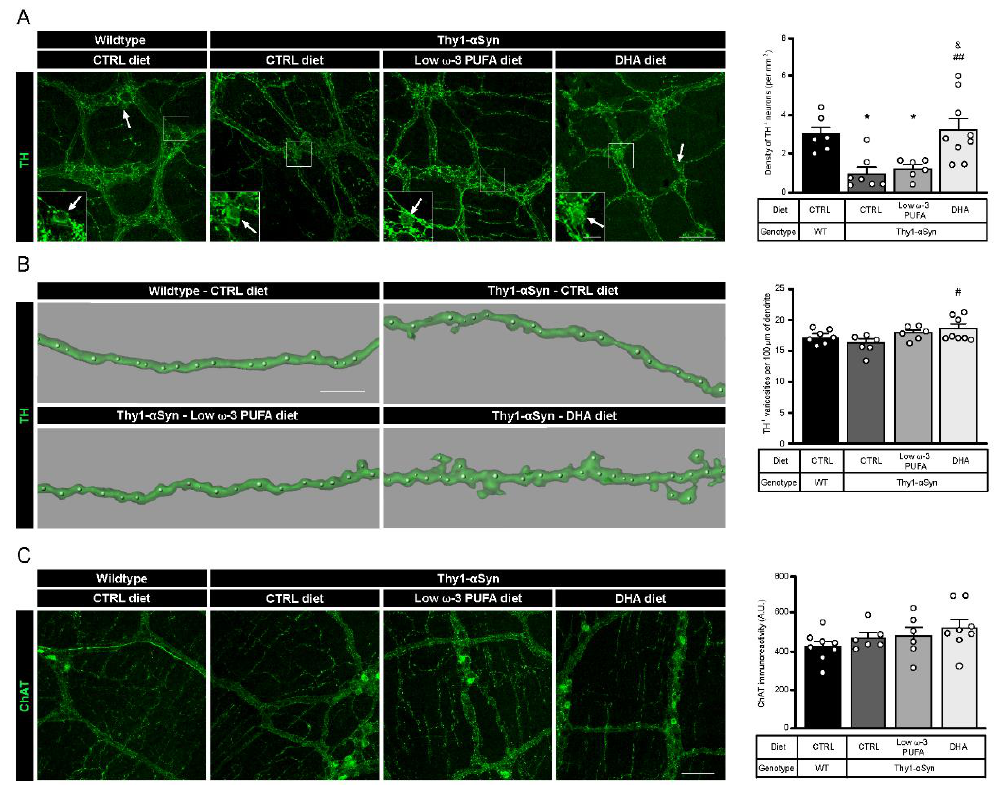
Figure 1. A DHA-enriched diet restores dopaminergic neuron integrity. ( A ) Photomicrographs of enteric TH + neurons (green) and their cell body, as indicated by the white arrow. They show a lower number of dopaminergic cell bodies in the myenteric plexus in the Thy1-αSyn model compared with the wild-type littermates. However, a DHA-enriched diet protected against the decrease in dopaminergic neuron level (one-way analysis of variance (ANOVA): p = 0.0009). Scale bar = 60 µm; Close-up scale bar = 15 µm. ( B ) Three dimensional images of TH + dendrites (green) and varicosities (white dots) show an increase of varicosities per 100 μm of dendrites in transgenic mice fed with DHA-enriched diet compared to control diet. No difference was observed between the Thy1-αSyn mice and the wild-type littermates (one-way ANOVA: p = 0.0396). Scale bar = 10 μm. ( C ) Photomicrographs and immunoreactive quantification of ChAT (green) shows no difference between models or among dietary groups (one-way ANOVA: p = 0.2987). Scale bar = 60 μm. Tukey’s post-hoc tests: * p < 0.05 compared with wild-type mice; # p < 0.05, ## p < 0.01 compared with Thy1-αSyn on control diet; & p < 0.05 compared with Thy1-αSyn on low ω-3 PUFA diet. Abbreviations: A.U., arbitrary unit; ChAT, choline acetyltransferase; CTRL, control; DHA, docosahexaenoic acid; TH, tyrosine hydroxylase; WT, wild-type.